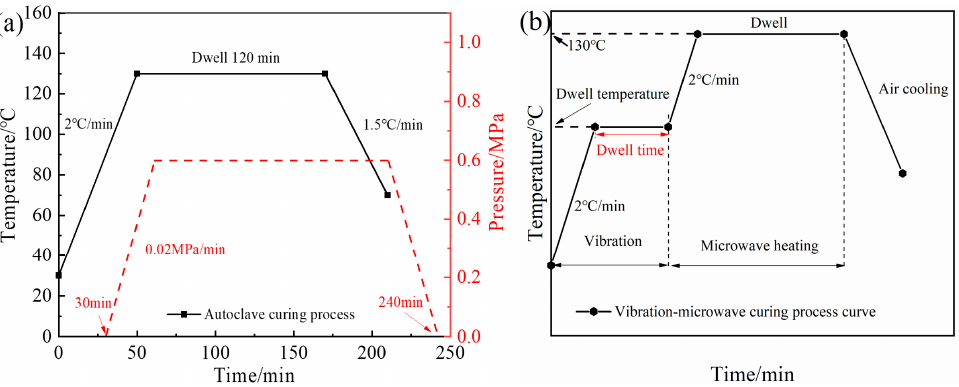
Figure 2. Composite curing process curve, ( a ) autoclave curing process, ( b ) vibration pretreatment microwave curing process.